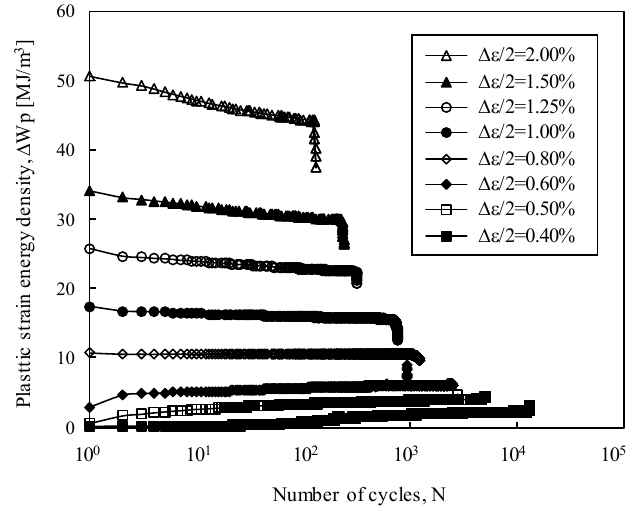
Figure 11. Cyclic plastic strain energy density versus number of cycles.